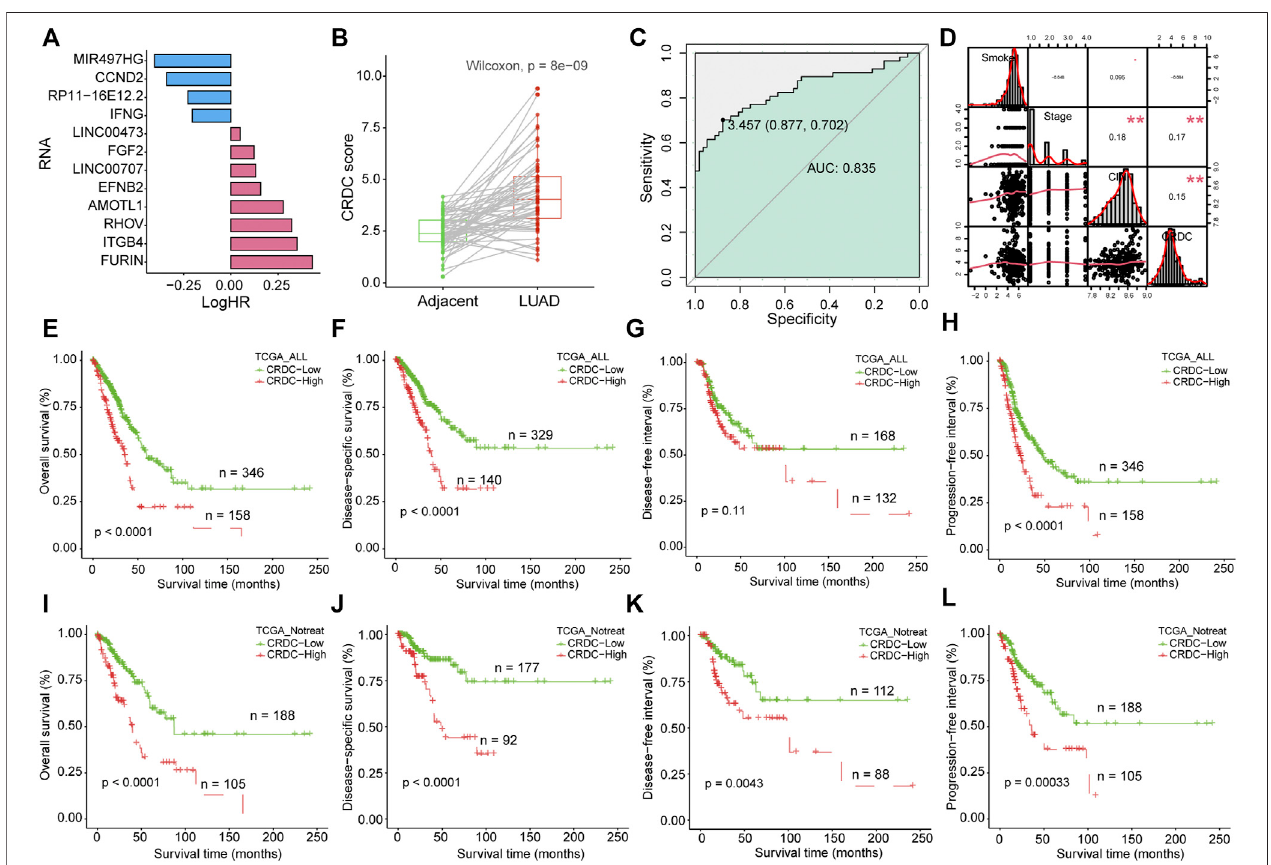
FIGURE4| FormulationoftheCRDCriskscoreandprognosticanalysis. (A) Barplotdepictedthelog-transformedhazardratioofCRDCgenesintheunivariateCox regression model. (B) Boxplot for CRDC of LUAD and adjacent paired samples. The green column indicated adjacent samples, and the red column indicated LUAD tissues. (C) ROC curve of CRDC in discriminating LUAD patients from adjacent control samples. The green color indicated AUC. (D) Spearman correlation analysis of smoking,clinicalstage,CIN, andCRDCriskscore.Kaplan – MeiersurvivalcurvesoftheCRDCriskscorein (E – H) allLUADpatients(TCGA_ALL,forshort)and (I – L) patients without postoperative treatment (TCGA_Notreat, for